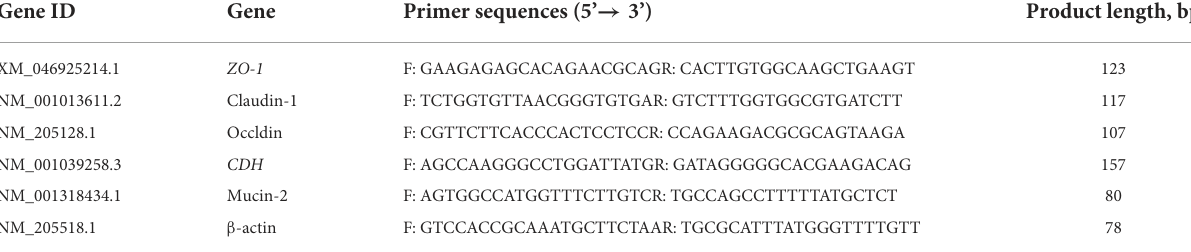
TABLE 3 The primers for quantitative real-time PCR.